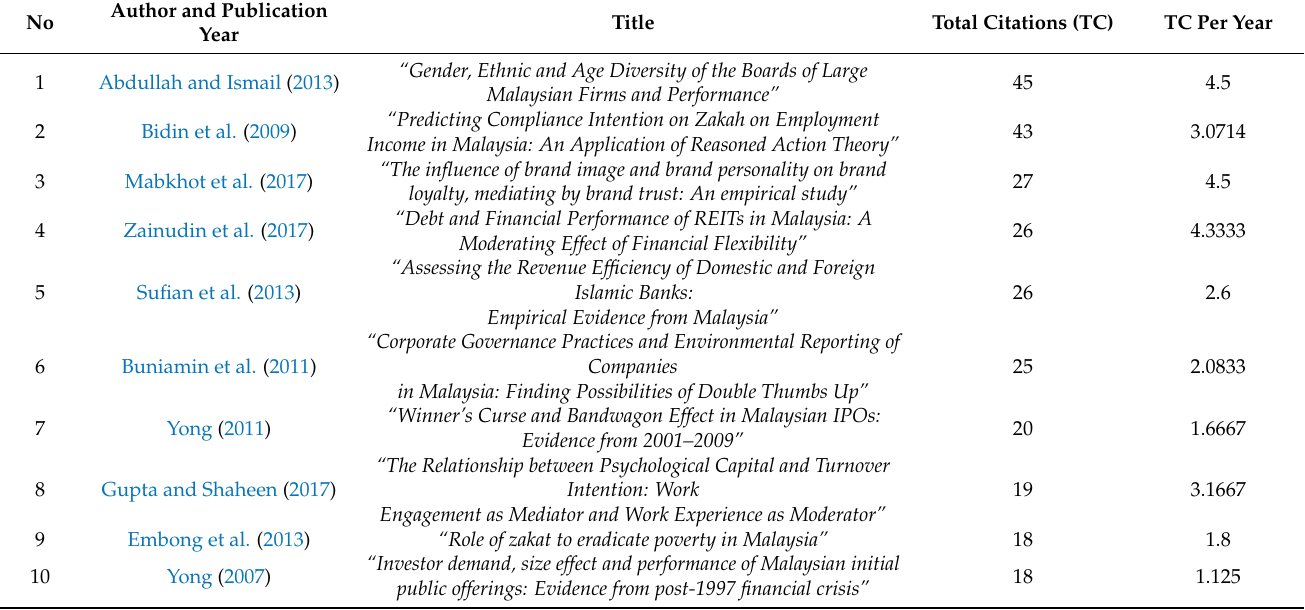
Table 5. The 10 Most Influential